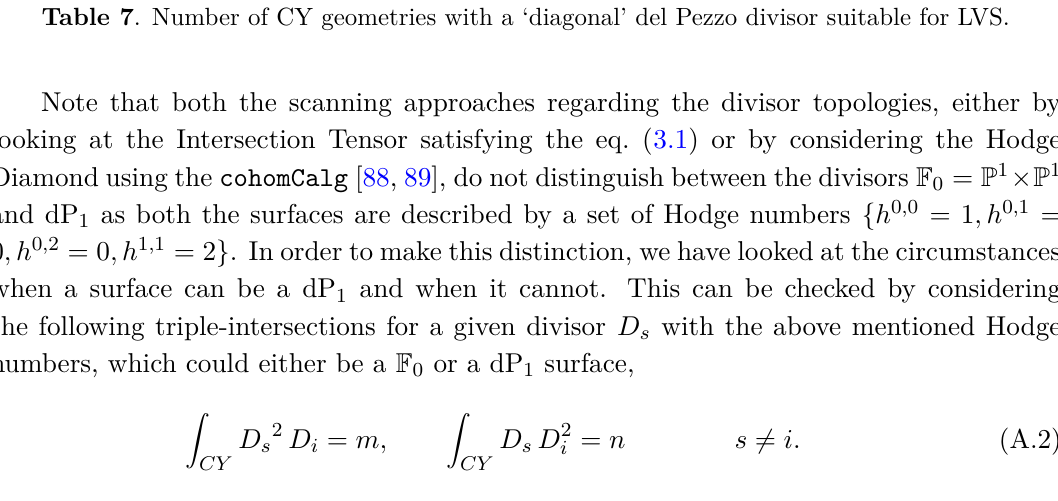
Table 7 . Number of CY geometries with a ‘diagonal’ del Pezzo divisor suitable for